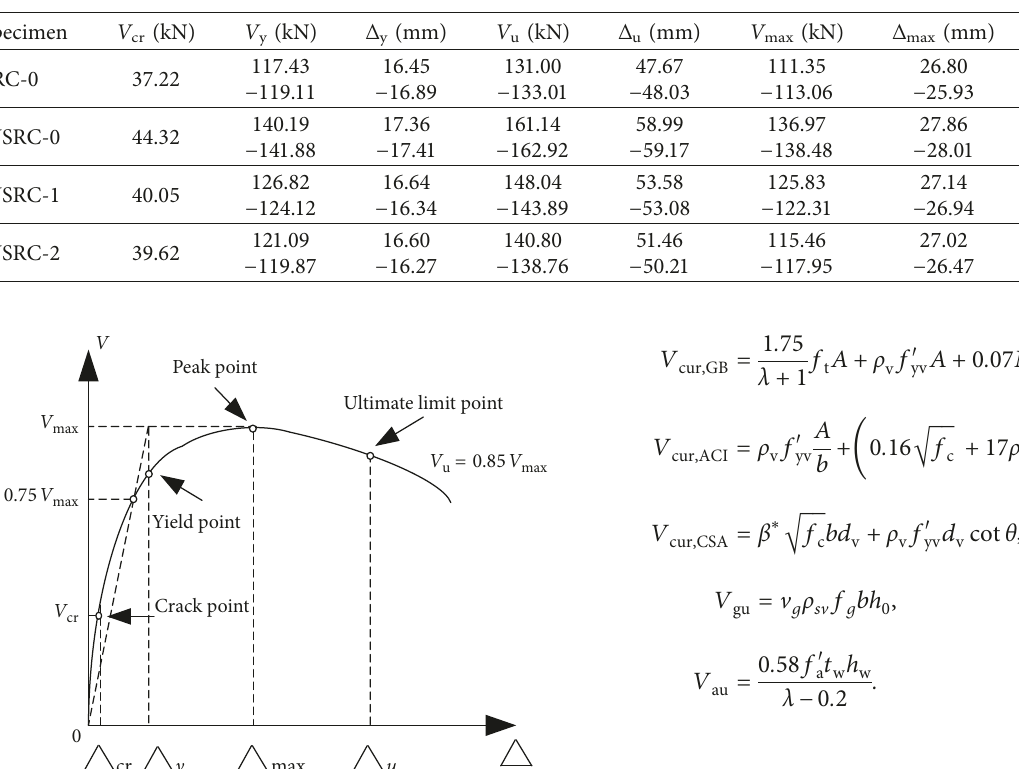
Table 1: Characteristic points of backbone curves.